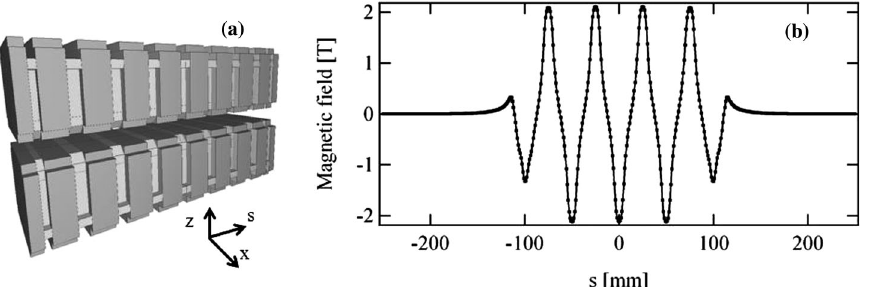
FIG. 2. Three period wiggler (a) designed with RADIA and TOSCA composed of permanent magnets (grey) and vanadium permendur poles (light grey). In (b), calculated magnetic field with RADIA ( ) and TOSCA 3D ( j ) at minimum